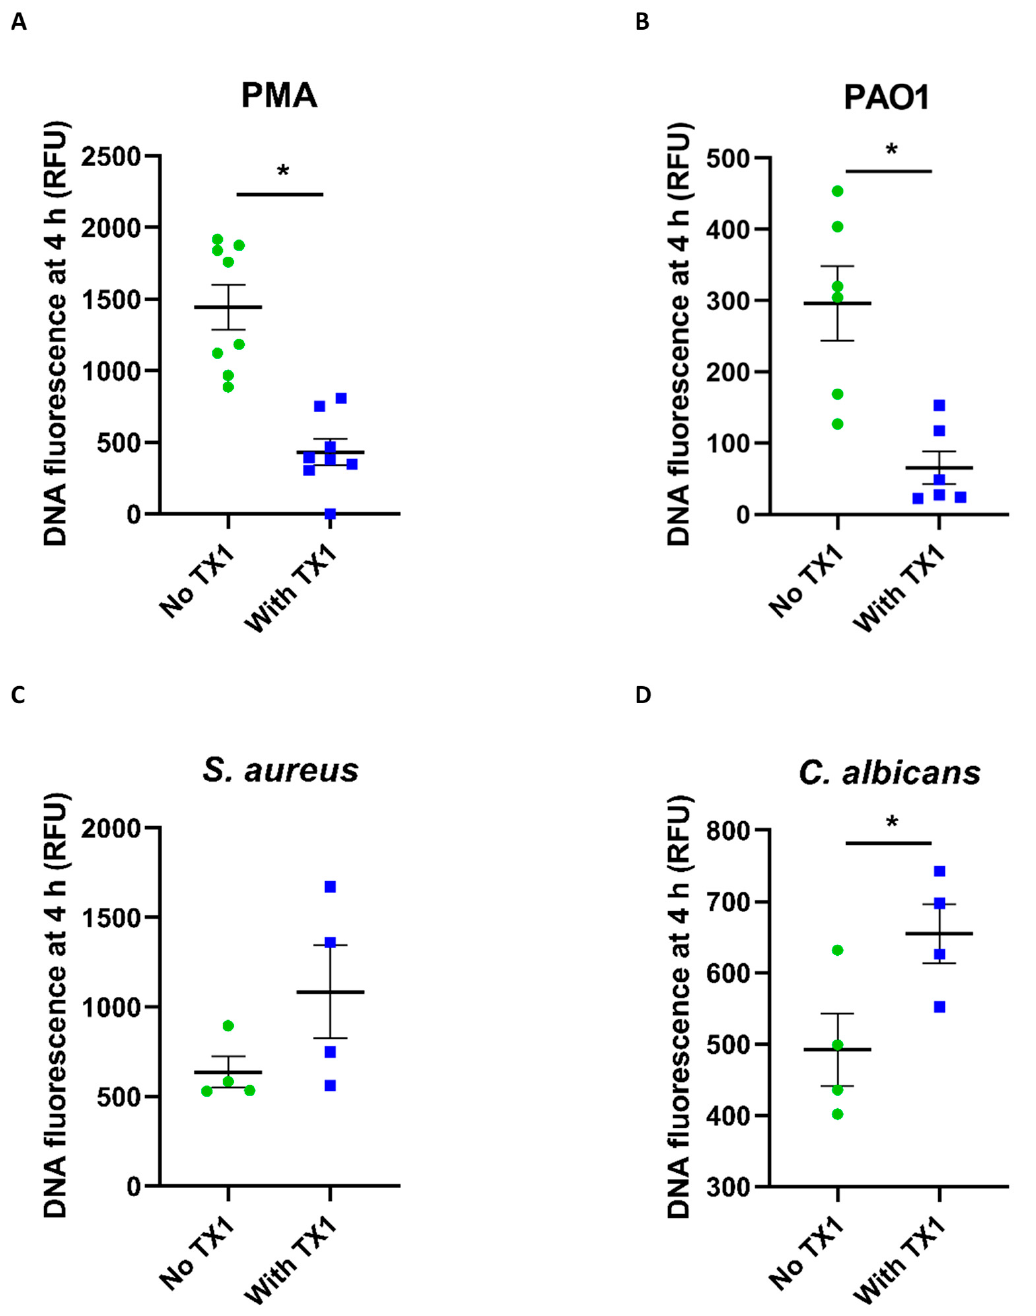
Figure 7. Effect of MPO inhibition on NET formation. Neutrophils were stimulated with ( A ) PMA (20 nM), ( B ) P. aeruginosa PAO1 (MOI 10), ( C ) S. aureus (MOI 10), or ( D ) C. albicans (MOI 2) in the presence or absence of the MPO inhibitor thioxanthine 1 (TX1) (10 µM), and DNA fluorescence was measured after 4 h. The fluorescence of control (unstimulated) cells was subtracted from that of stimulated cells. Data are means (SE) of 4–8 separate experiments. *, significantly different than without TX1 ( p < 0.05 by paired t -test).